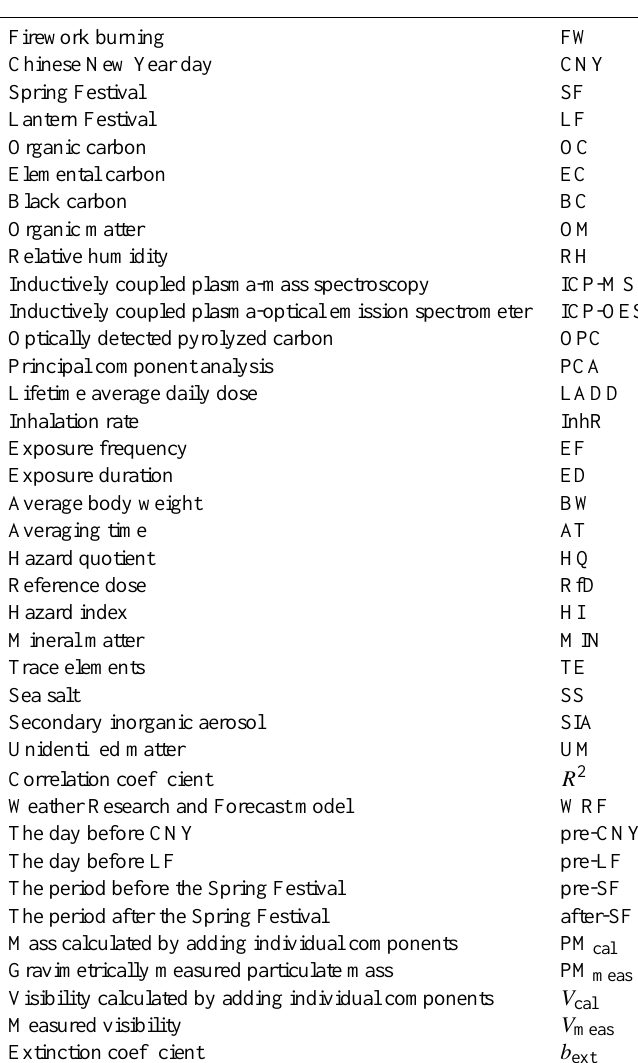
Table A1. Abbreviations